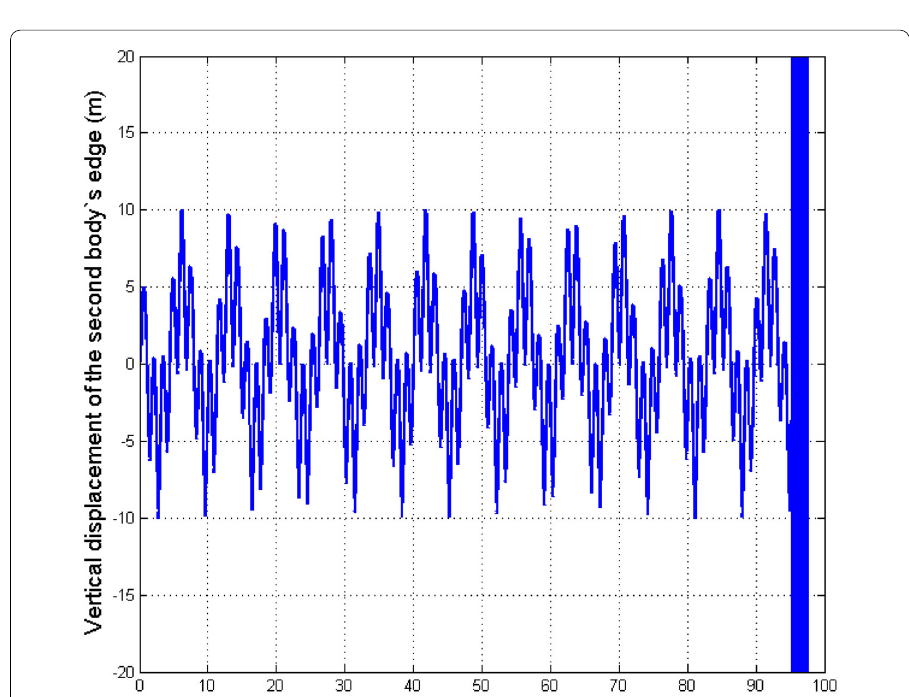
Fig. 17 Multi-body snap-shots